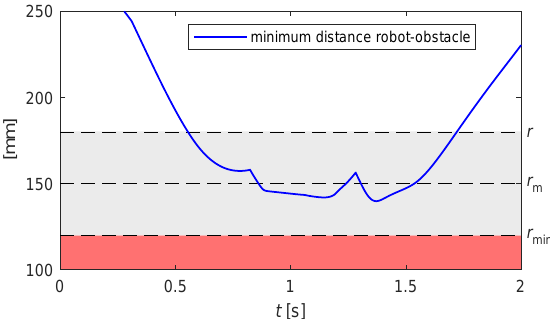
Figure 16. Example 3: minimum distance robot-obstacle for the motion shown in Figure 15.